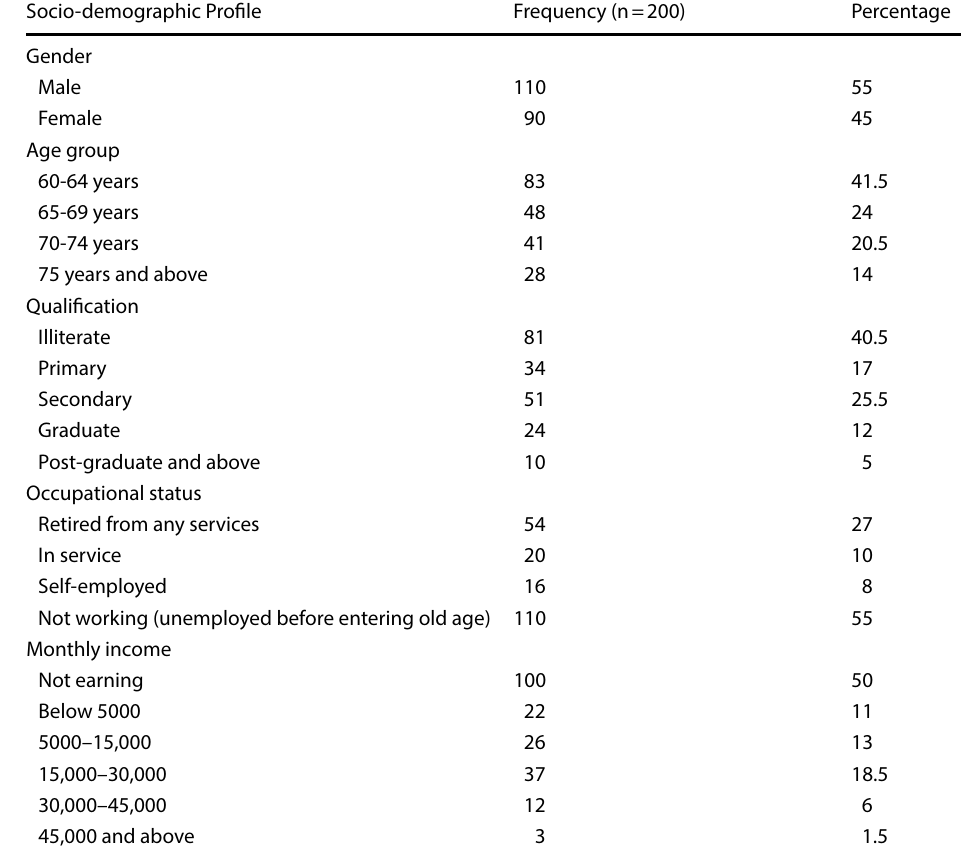
Table 2 Distribution of respondents based on difficulties experienced by elderly non-dependent on assistive devices (n = 200)